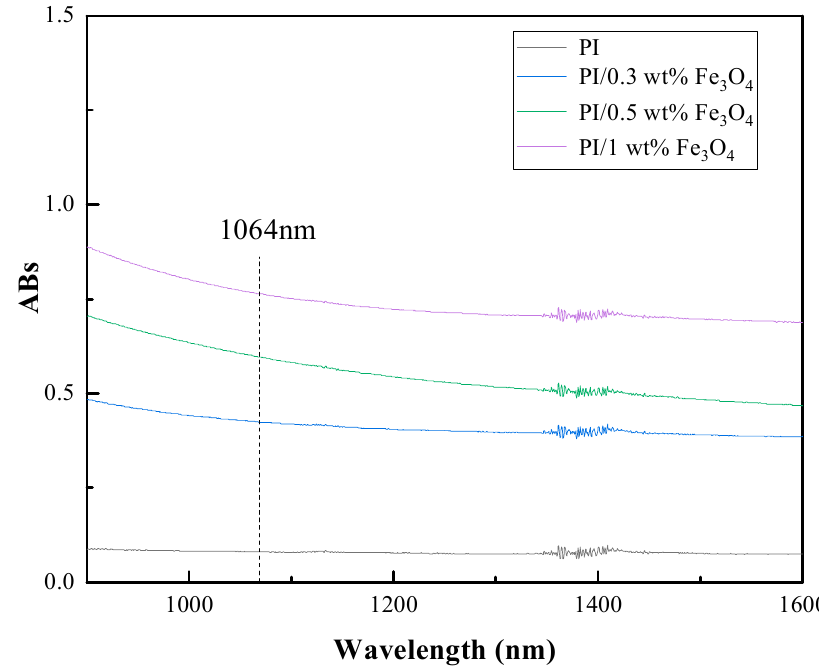
Figure 2. Near-infrared light absorption pattern of Fe 3 O 4 /PI nanocomposite film. To identify the composition and crystalline phase of the hybrid film (CNS-1 wt% Fe 3 O 4 ) after laser ablation, the XRD patterns of the powder directly scratched from the film were analyzed, as shown in Figure 3. The broadened Bragg peaks at 26 ◦ and 43 ◦ are part of the characteristic diffraction pattern of turbostatic carbon nanostructures; a disorder stacked lattice planes along the (002) direction of graphitic carbon [15,16]. Another set of sharp diffraction peaks can be indexed to cubic trans spinel structured Fe 3 O 4 (PDF 79- 0419). Neither metallic iron nor iron carbides were detected in the samples after the laser ablation, in consideration of the possible carbothermal reduction reaction at the extreme high temperature and the instantaneous plasma states induced by laser beams. In other words, Fe 3 O 4 nanopowder filled in the carbon matrix was stable under the irradiation of a 1064 nm laser at a high